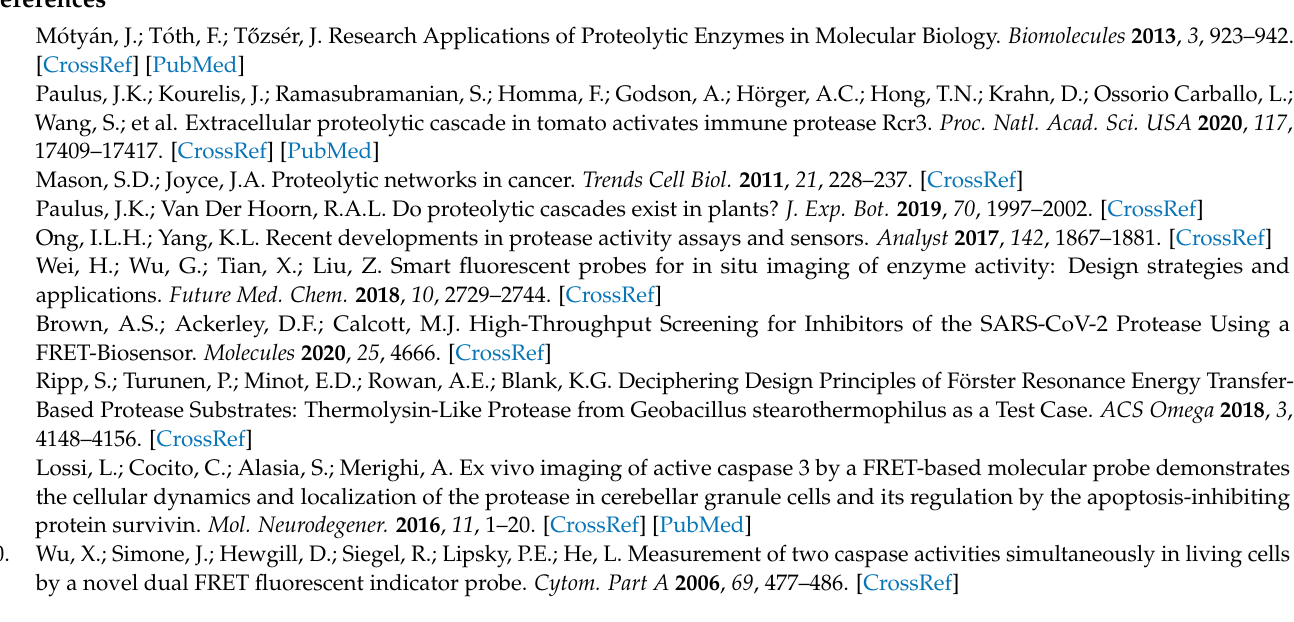
sis of chemically cleaved compound from Resin T5. Figure S8: LC-MS analysis of chemically cleaved compound from Resin C3. Figure S9: LC-MS analysis of chemically cleaved compound from Resin C4. Figure S10: LC-MS analysis of chemically cleaved compound from Resin C5. Figure S11: LC-MS analysis of chemically cleaved compound from Resin C7. Figure S12: LC-MS analysis of chemically cleaved compound from Resin T7. Figure S13: Trypsin probe (chemically cleaved from Polystyrene Wang resin). Figure S14: LC-MS analysis of purified trypsin probe. Figure S15: 1 H NMR spectrum of purified trypsin probe. Figure S16: Chymotrypsin probe (chemically cleaved from TentaGel XV RAM resin). Figure S17: LC-MS analysis of purified chymotrypsin probe. Figure S18: 1 H NMR spectrum of purified chymotrypsin probe. Figure S19: Enzymatically cleaved fragment from the trypsin probe. Figure S20: LC-MS analysis of enzymatically cleaved fragment from the trypsin probe. Figure S21: Enzymatically cleaved fragment from the chymotrypsin probe. Figure S22: LC-MS analysis of enzy- matically cleaved fragment from the chymotrypsin probe. Table S1: Time-dependent fluorescence response of trypsin linker (TentaGel XV RAM resin). Table S2: Time-dependent fluorescence response of trypsin linker (H-Rink amide ChemMatrix resin). Table S3: Time-dependent fluorescence response of trypsin linker (Rink Amide PEGA resin). Table S4: Time-dependent fluorescence response of chymotrypsin linker (Rink Amide PEGA resin). Table S5: Fluorescence response—determination of the lowest detectable concentration of trypsin. Table S6: Fluorescence response—determination of the lowest detectable concentration of chymotrypsin. Table S7: Fluorescence response—simultaneous detection of trypsin and chymotrypsin. Table S8: Fluorescence response—the lowest detectable concentration of chymotrypsin at different wavelengths. Table S9: Stability of Rink Amide PEGA resin-anchored trypsin linker. Table S10: Stability of Rink Amide PEGA resin-anchored chymotrypsin